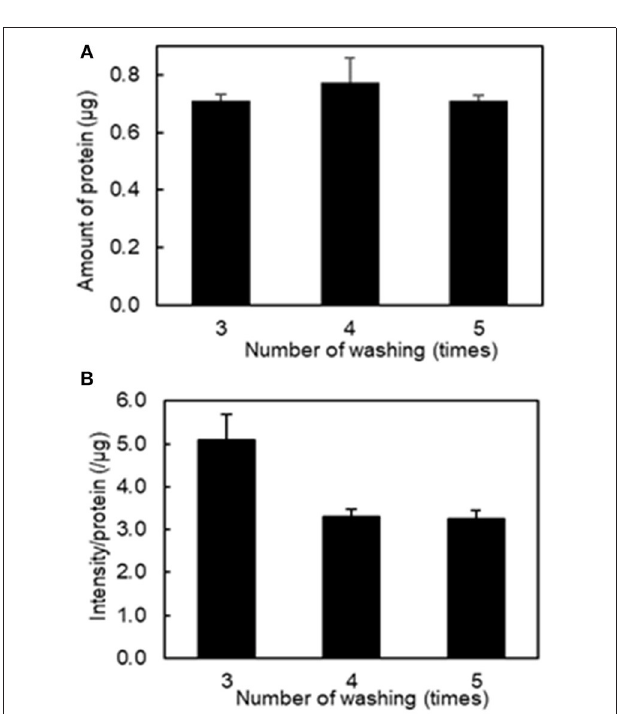
FIGURE 2 | Effect of the number of washing on the amount of protein and fluorescence intensity in the aggregation of H12-L551 liposomes (final concentration: 200 µ M) with activated platelets ( n = 1). (A) Amount of protein after washing of aggregated sample between three and five times. (B) The mean fluorescence intensity per protein of aggregated sample after washing between three and five times. Error bars indicate SD of three determinations.